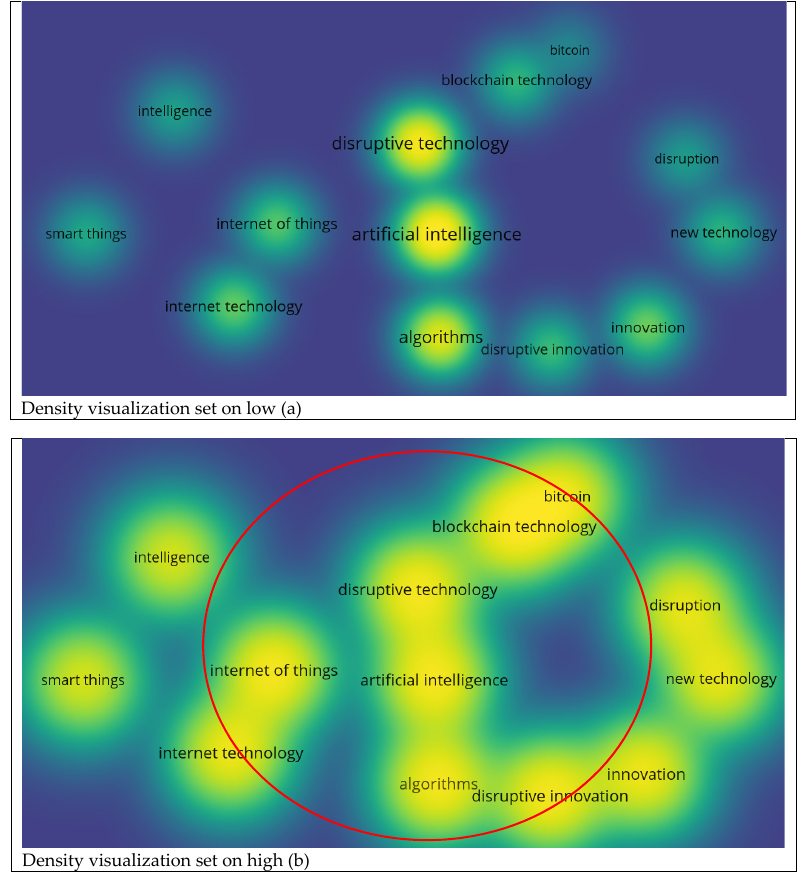
Figure 4. The density visualization ( a , b ) between the top 3 disruptive technologies within the resulting list of papers (n = 97). RQ3—Which domains were impacted by AI, and what are the other top disruptive technologies?